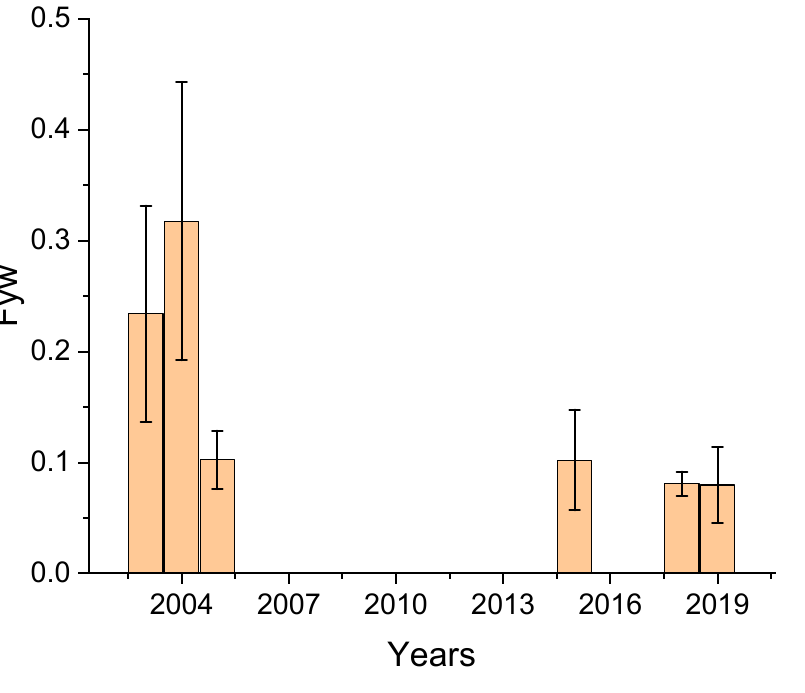
Figure 4. Fyw over the monitoring